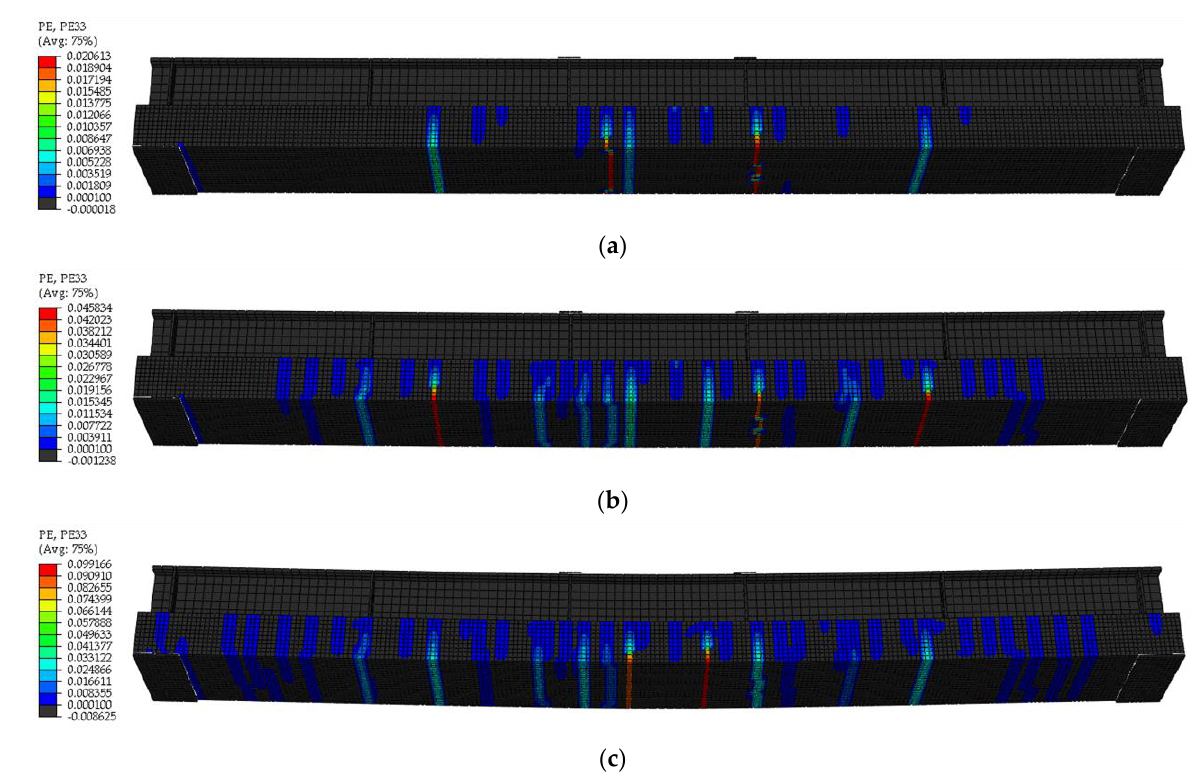
Figure 8. Crack development for a UHPC layer ratio of 0: ( a ) applied load equals 100 kN; ( b ) applied load equals 290 kN; ( c ) applied load equals 330 kN.